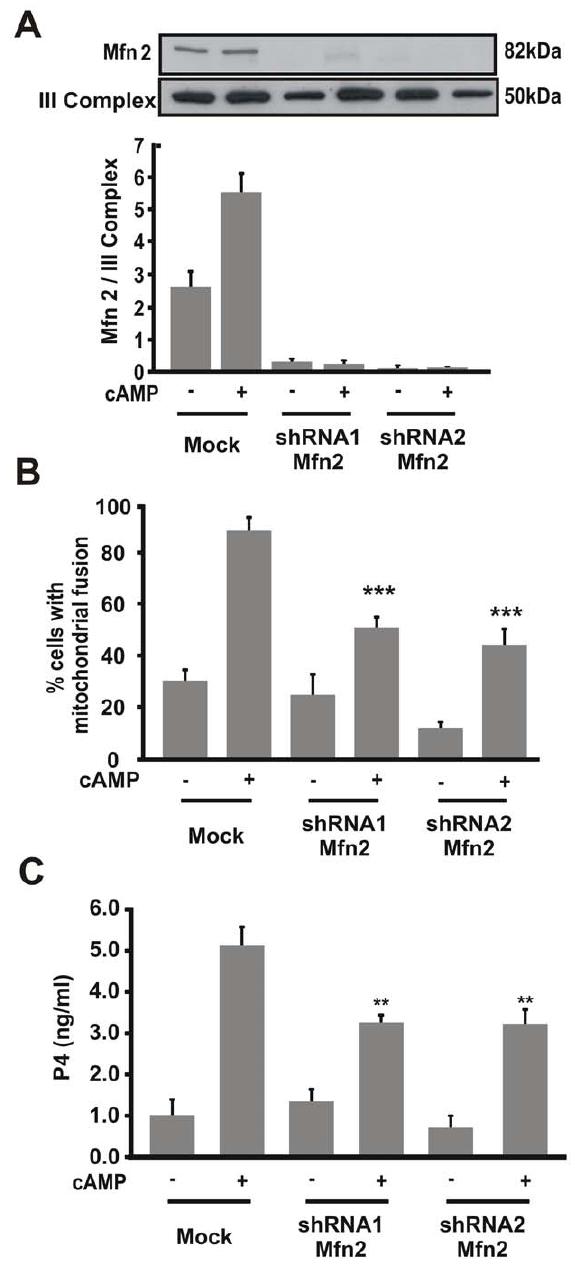
Figure 7. Mfn2 protein is necessary for steroid synthesis. MA-10 cells were transfected with a plasmid containing different shRNA Mfn2 (shRNA1 or shRNA2). After 48 h, cells were stimulated with 8Br-cAMP (0.5 mM) for 1 h. A. Isolated mitochondrial proteins were obtained and western blotting was performed. Membranes were sequentially blotted with anti-Mfn2 and anti-III Complex antibodies. An image of a representative western blot is shown. For each band, the OD of the expression levels of Mfn2 protein was quantified and normalized to the corresponding III Complex protein. The relative levels of Mfn2 protein are shown. B. Cells were fixed and scored as previously described. Quantitative analysis of mitochondrial fusion is shown. The results are expressed as the means 6 SEM of three independent experiments. ** P , 0.01 vs. cAMP mock. C. P4 levels were determined by RIA in the incubation media. Data represent the means 6 SEM of three independent experiments and expressed as ng/ml. ** P , 0.01 vs. 8Br- cAMP mock.